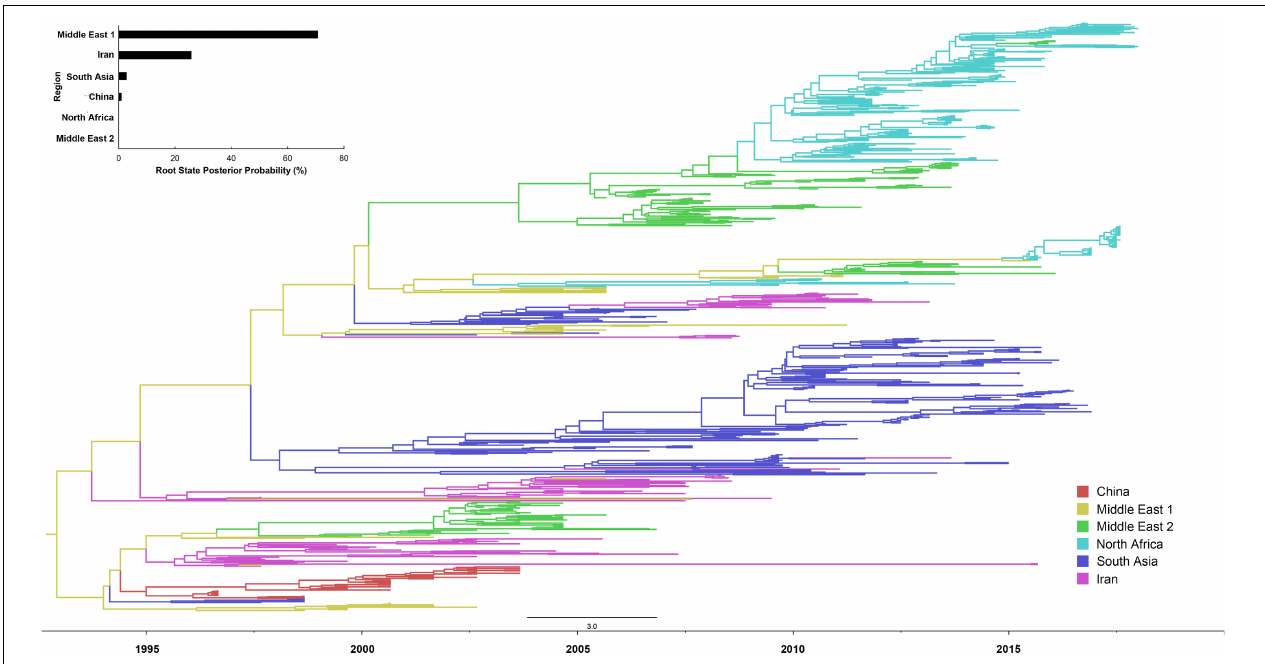
FIGURE 1 | Bayesian evolutionary tree of global LPAI H9N2 viruses based on the nucleotide sequence of the HA gene between 1997 and 2018. Locations were assigned to six regions: Middle East 1 (Saudi Arabia, United Arab Emirates and Iraq), Middle East 2 (Jordan, Lebanon and Israel), Africa (Egypt, Morocco, Libya, Tunisia and Algeria), East Asia (China), West Asia (Iran), and South Asia (Bangladesh, India and Pakistan). The posterior probability of each location acting as transmission hub, i.e., root state posterior probability, was also